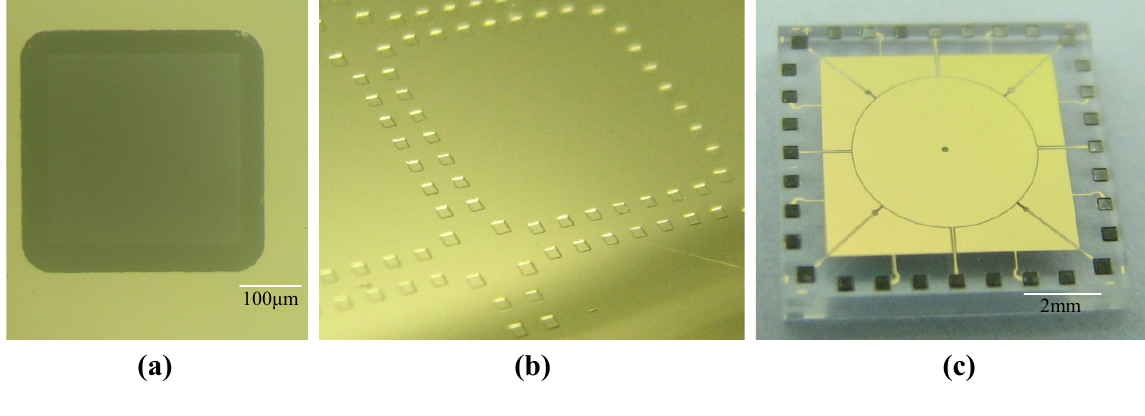
Figure 8. Fabrication results of the top stator: (a) Microphotograph of one of the etched pits after removal of photoresist mask; (b) Photograph of partial wafer after Cr/Pt/Au layer deposited; (c) Photograph of one diced top stator, with SnAg electroplated within the